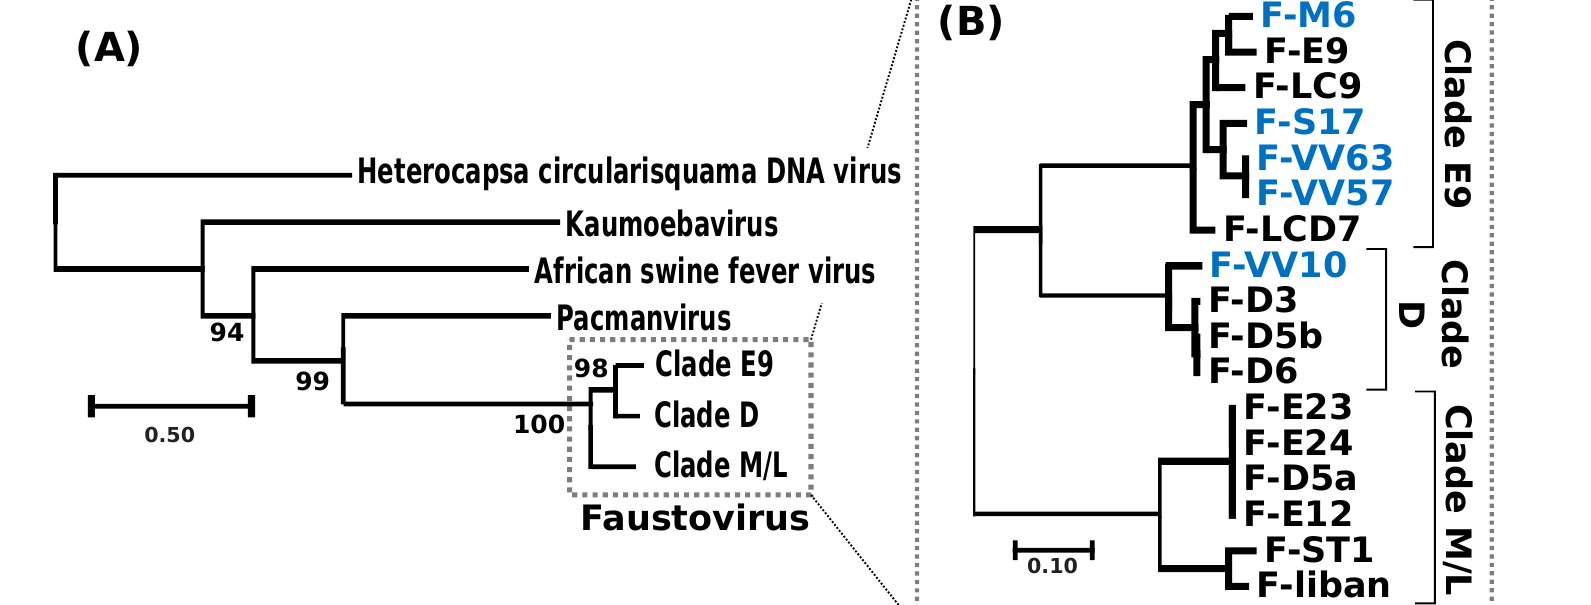
Figure 2. Phylogenetic relationships between FVs and virus relatives. ( A ) Unrooted phylogenetic tree of FVs and virus relatives reconstructed using the viral DNA polymerase as a marker. FV clades have been collapsed for clarity. Details of the clade compositions are given in B. SH-like local supports for branches are indicated beside nodes. The scale bar indicates the number of amino-acid substitutions per site. ( B ) Phylogenetic tree of FVs reconstructed from the concatenation of the alignments of 267 single-copy core FV proteins. All branches received maximal SH-like local support. Names of the newly sequenced FV strains are shown in Figure 2: Phylogenetic relationships between FVs and virus relatives